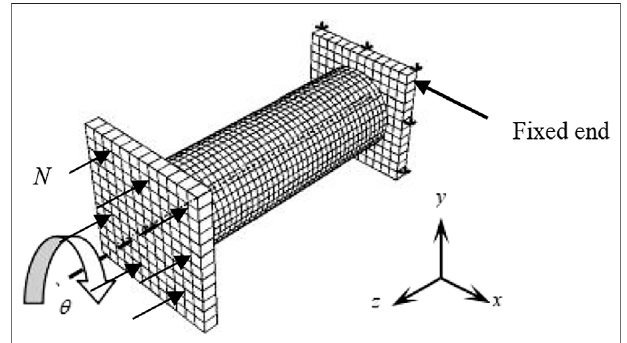
FIGURE 11 | Boundary conditions for fi nite element simulation of specimens.